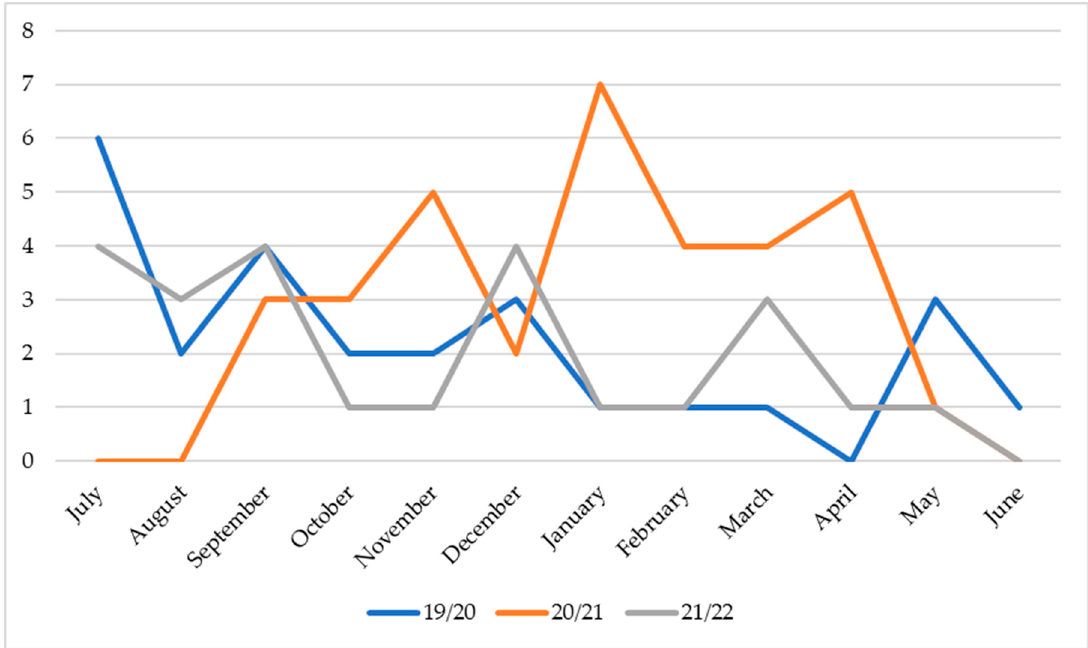
Figure 4. Frequency of injuries per month